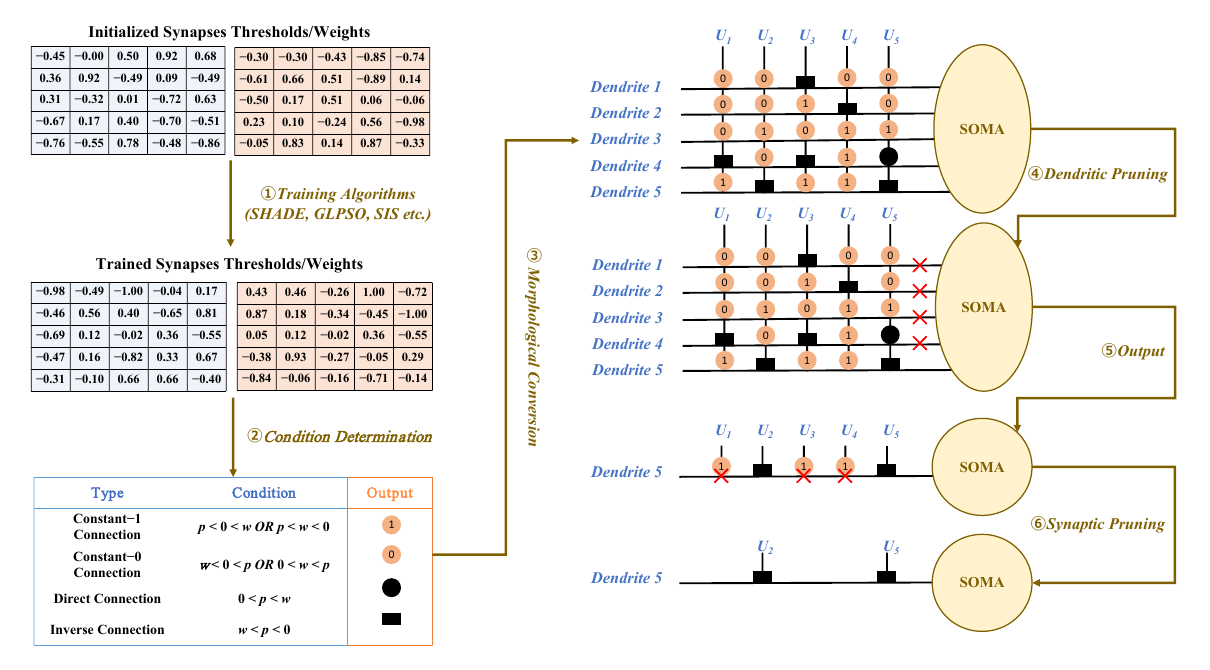
Figure 2. Learning process of a